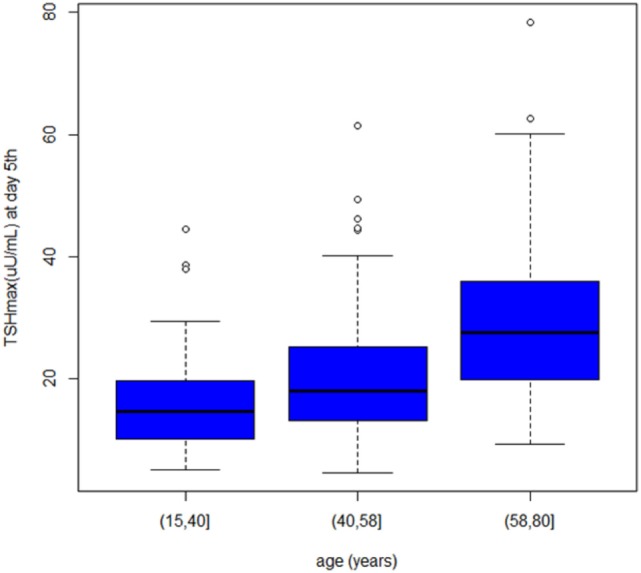
TSH peaks by age (range on day 5).